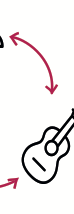
Figure 1. The interactive